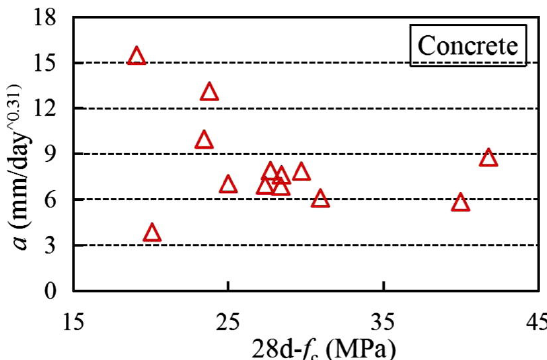
Pasupathy et al. [39] surveyed the durability of a pre-